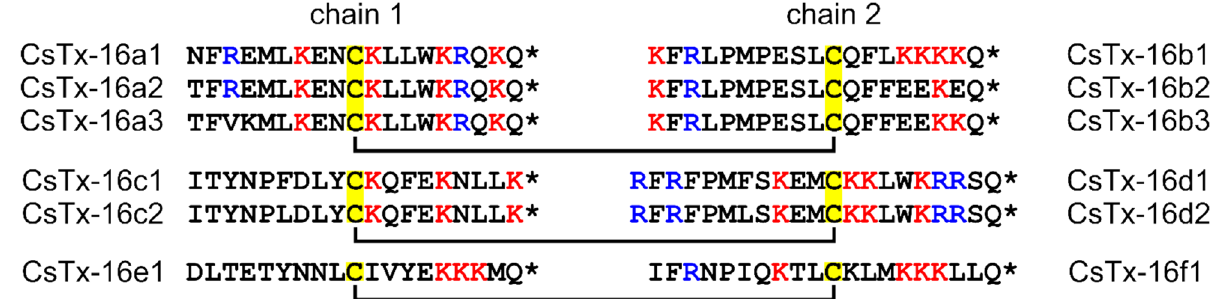
Figure 8. Overview on different CsTx-16 two-chain peptides. Three main variants of CsTx-16ab, CsTx-16cd, CsTx-16ef, and some sub-variants are presented. Cationic amino acid residues are colored in blue (Arg) and red (Lys) and Cys is highlighted in yellow. The C-terminal amidation is indicated with asterisks